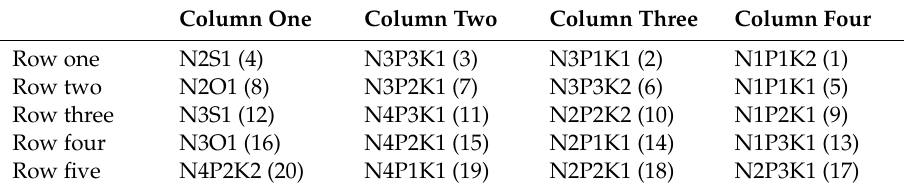
Table 1. The setup of the experiment for maize. The number represents the plots in Figure 1. The abbreviations are listed as: nitrogenous fertilizer (N), phosphate fertilizer (P), potassium fertilizer (K), straw (S), and organic fertilizer (O). The different combinations of fertilizers were applied in each plot. The numbers after fertilizers are the amount of applied fertilizers. Column One Column Two Column Three Column Four